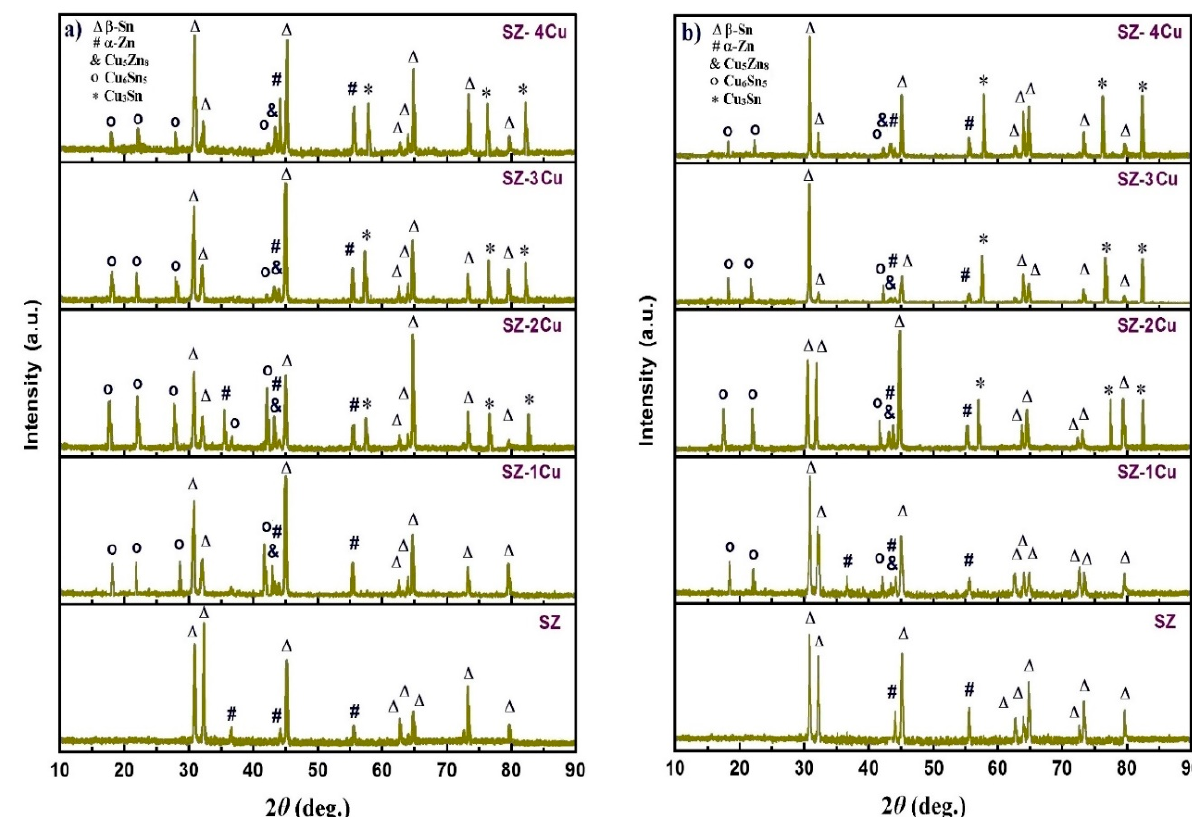
Figure 9. Representative XRD patterns of the investigated alloys aged at ( a ) 323 and ( b ) 398 K. With the addition of Cu, one peak with a small intensity of γ -Cu 5 Zn 8 IMC (JCPDS card No. 65-3157) is noticed at 43.3° owing to the interaction between copper and zinc during the solidification process of the studied alloys. Besides, it is detected the appear- ance of the diffraction peaks for the monoclinic η -Cu 6 Sn 5 IMC. The presence of this phase in the β -Sn matrix is assured by (JCPDS card No. 45-1488). The diffraction peaks for the hexagonal ε -Cu 3 Sn IMC (JCPDS card No. 01-1240) start to appear in the chart of SZ-2Cu alloy. The intensities of the diffraction peaks of Cu 3 Sn IMC seemed to be increased for SZ-